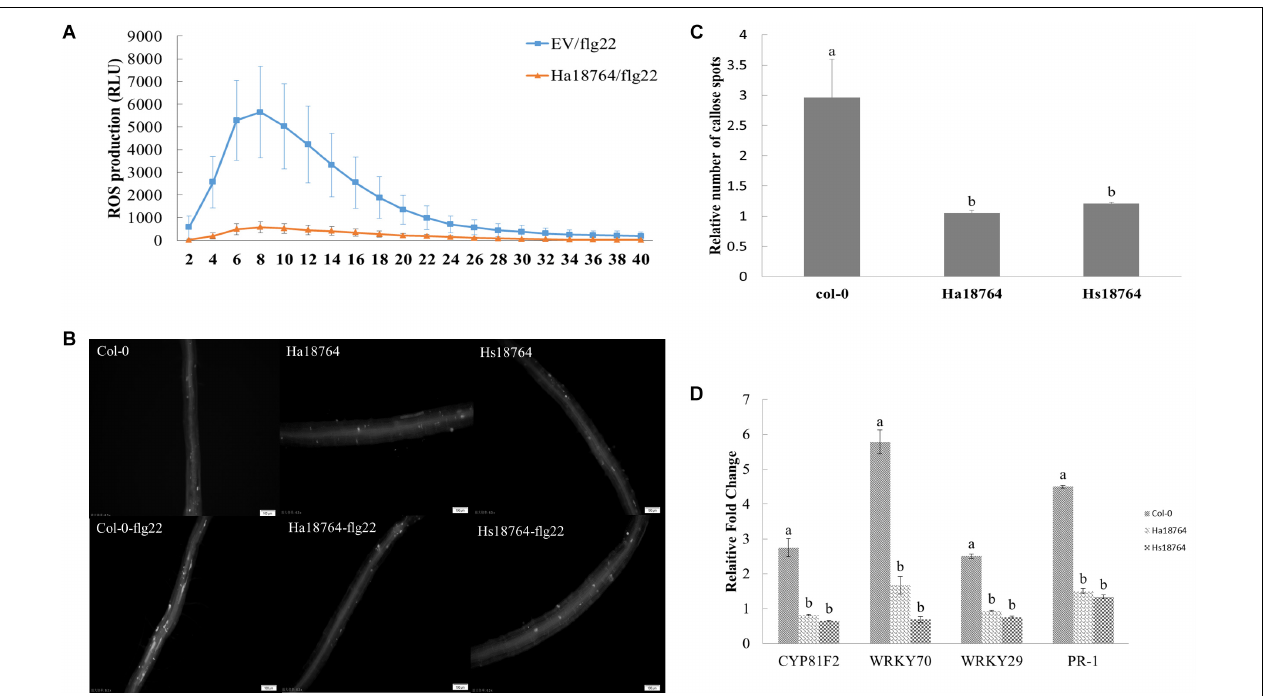
FIGURE 8 | Ha18764 suppresses PTI triggered by flg22. (A) Ha18764 suppressed flg22-mediated ROS production in Nicotiana benthamiana . The Agrobacterium tumefaciens strain GV3101 carrying Ha18764 , or the empty vector (EV) construct, was infiltrated into N. benthamiana leaves. A total of 18–24 infiltrated leaf disks were collected 48 h post-agroinfiltration and assayed for ROS production. (B) Ha18764 suppressed callose deposition. Ha18764 or Hs18764 transgenic and wild-type (WT, Col-0) Arabidopsis plants were treated with flg22; 24 h later, callose (white dots) in the roots was visualized by staining. Images were photographed in the field of approximately 2 mm 2 that captures the root area containing the root elongation zone. (C) Quantified relative numbers of callose. (D) Expression of plant defense genes. The mRNA expression levels of WRKY70 , WRKY29 , PR-1 , and CYP81F2 were measured by qPCR in Ha18764 or Hs18764 transgenic and WT plants treated with flg22. Shown are means of three independent biological experiments, each consisting of three technical